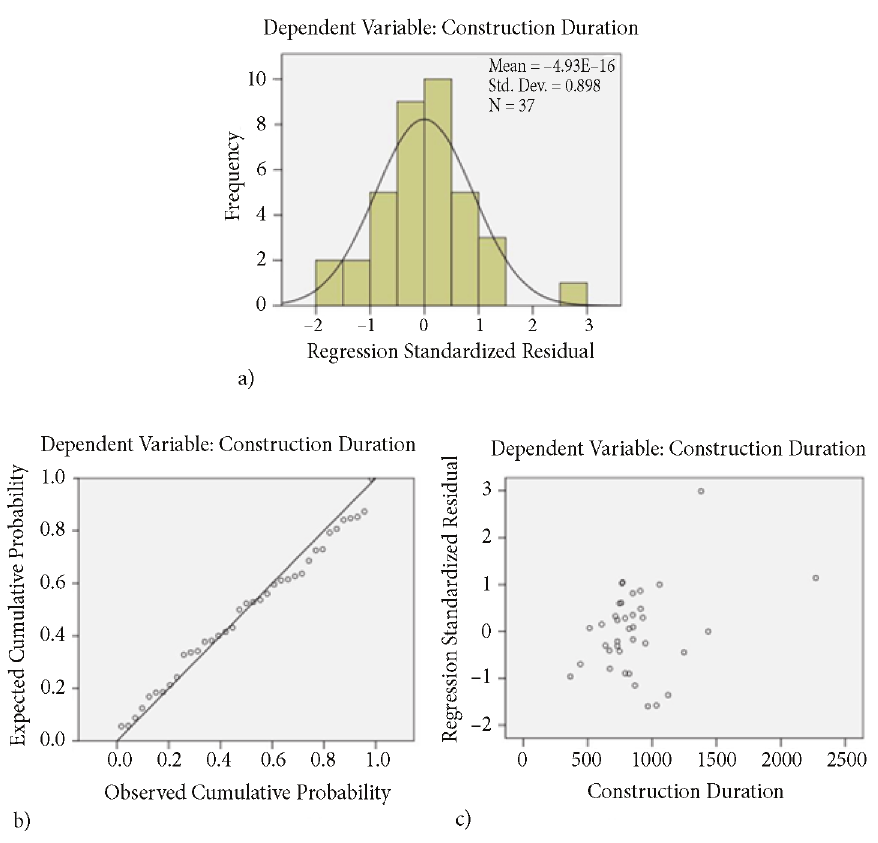
Figure 6. Result of residual analysis: a – regression standardized residual histogram; b – normal probability plot of standardized residual; c – scatter plot for dependent variable of standardized